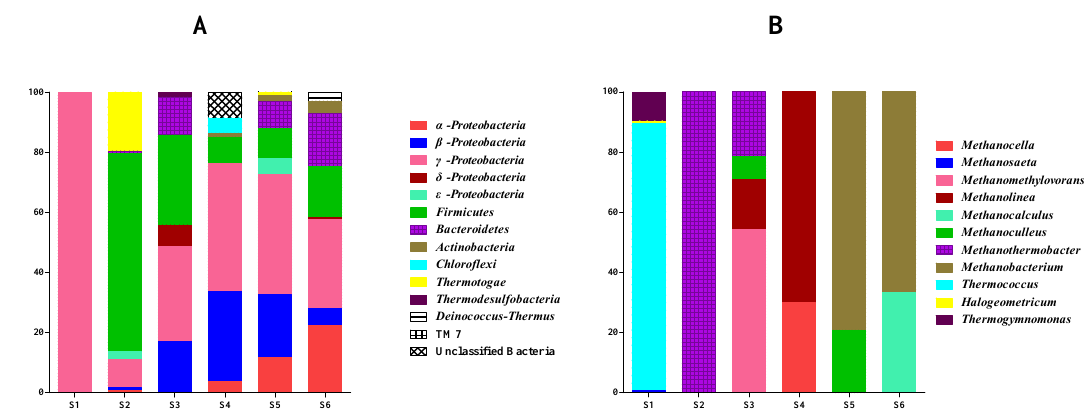
Fig. 5. Relative proportion of bacterial (A) and archaeal (B) taxa from 16S rRNA gene sequence clone libraries constructed from DNA extracted from production waters collected from oil reservoirs with temperatures 63, 58, 45, 37, 32 and 21 ◦ C. Sampling locations are as named in Table 1.